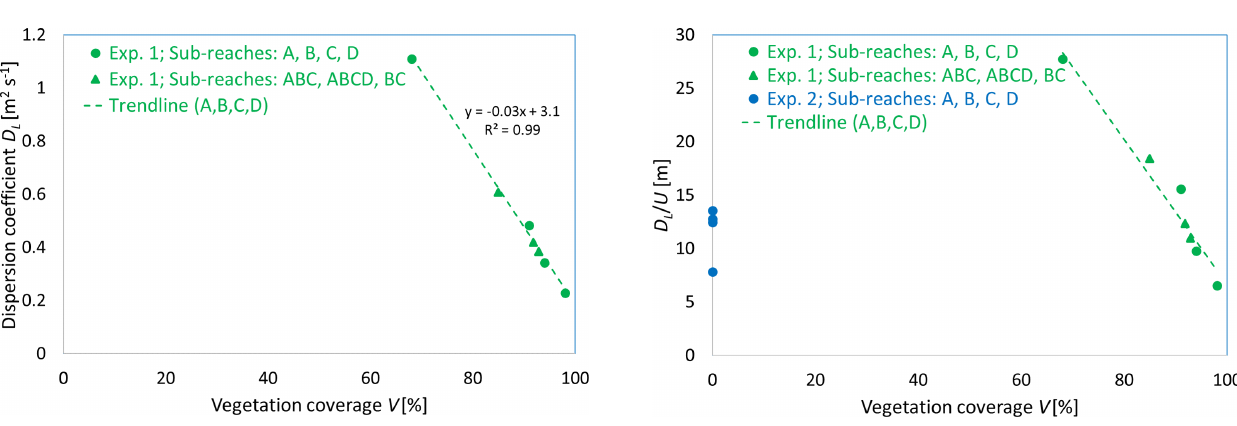
Figure 13. Longitudinal dispersion coefficient D L scale against the mean sub-reach velocity U depending on the vegetation cov- erage ( V